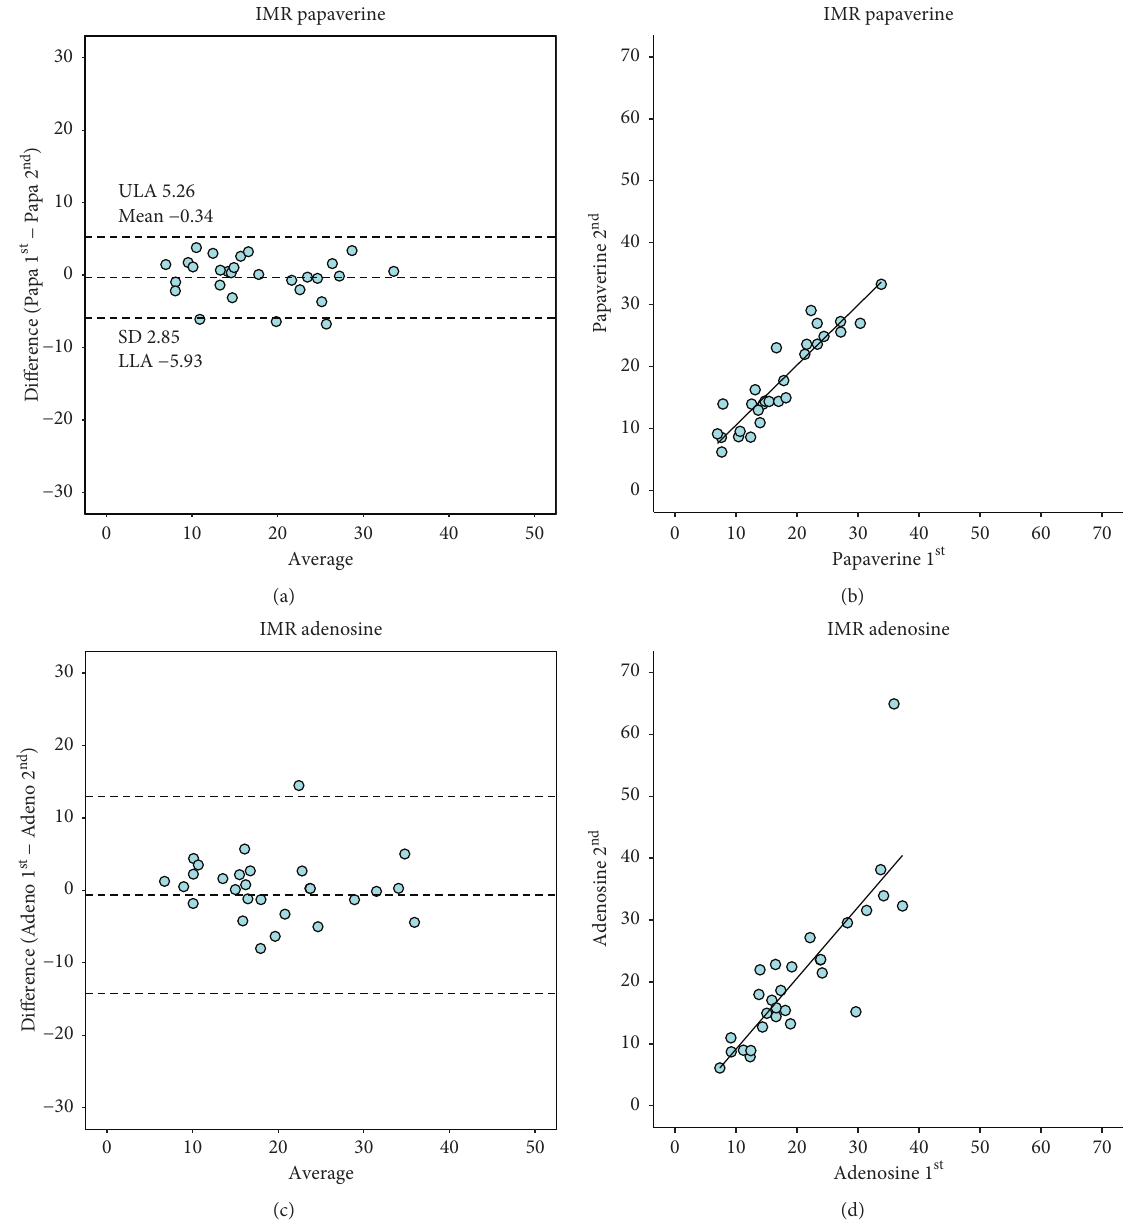
Figure 2: Reproducibility of IMR obtained with IC papaverine and IV adenosine. (a) Bland–Altman plot of IMR with repeated measures of papaverine. (b) Correlation of IMR measured with repeated measures of papaverine. (c) Bland–Altman plot of IMR measured with repeated measures of adenosine. (d) Correlation of IMR measured with repeated measures of adenosine. IMR, index of microvascular resistance; IC, intracoronary; IV, intravenous; Papa 1 st , first injection of papaverine; Papa 2 nd , second injection of papaverine; Adeno 1 st , first injection of adenosine; Adeno 2 nd , second injection of